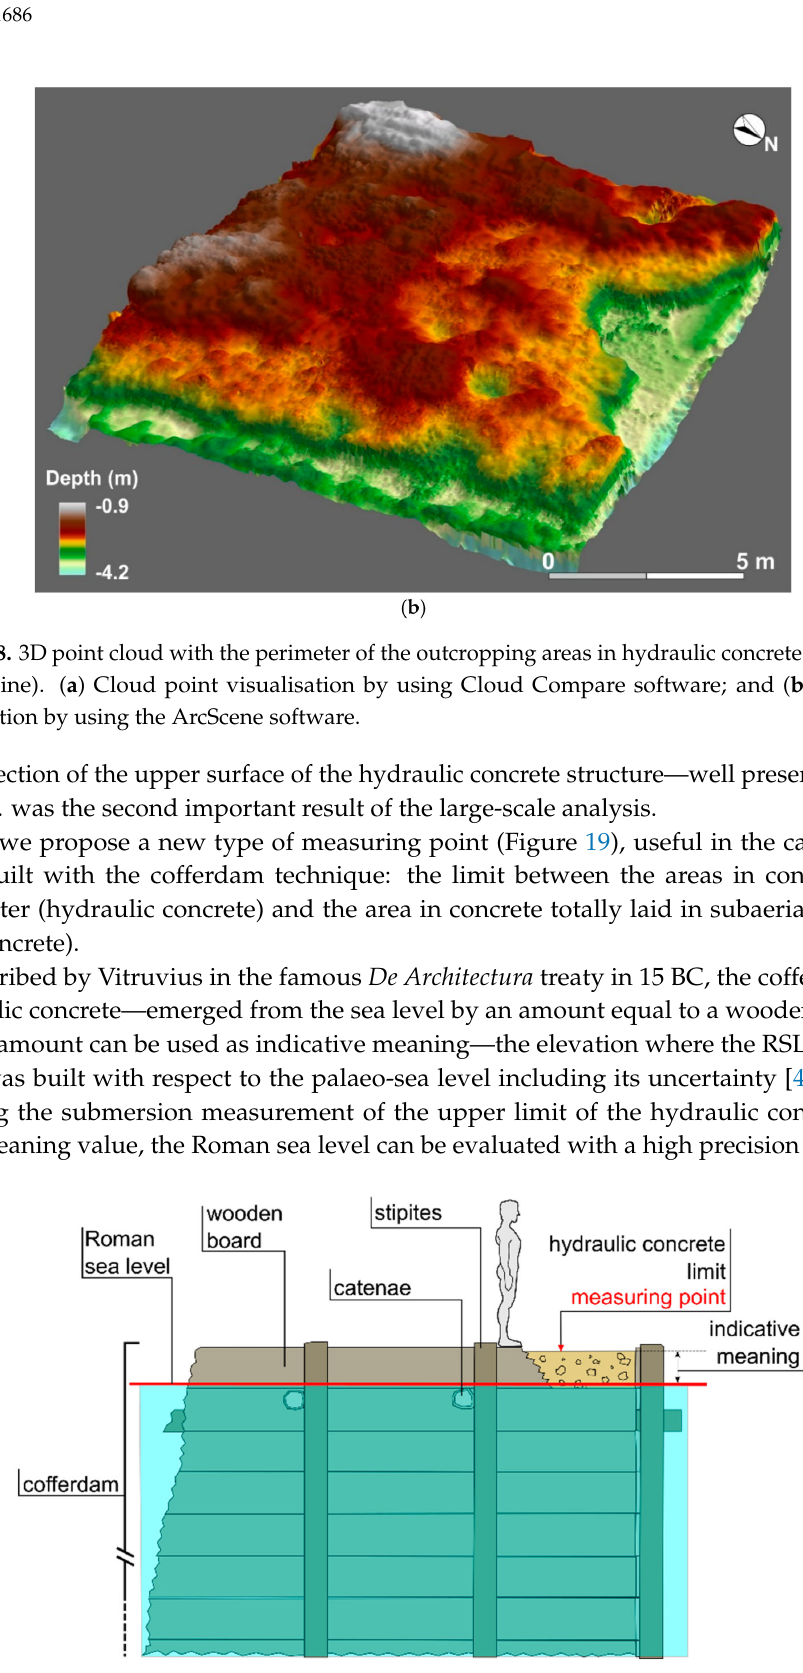
Figure 19. Sketch of the new type of measuring point useful in the case of port-like structures built in hydraulic